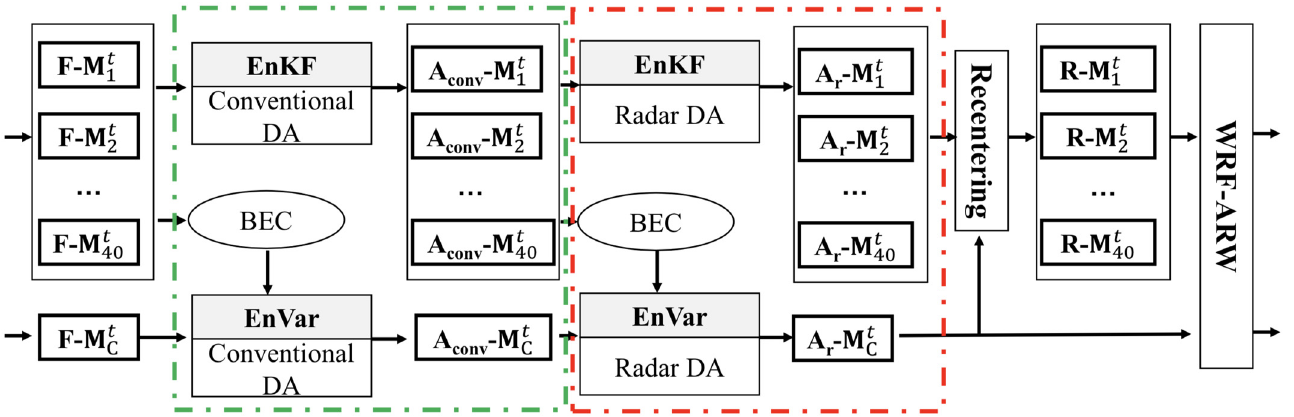
Figure 1. Flowchart for the EDA system at a particular DA cycle, t. The green box indicates the assimilation of conventional observations, and the red box includes the assimilation of radar- reflectivity observations. See text for details.